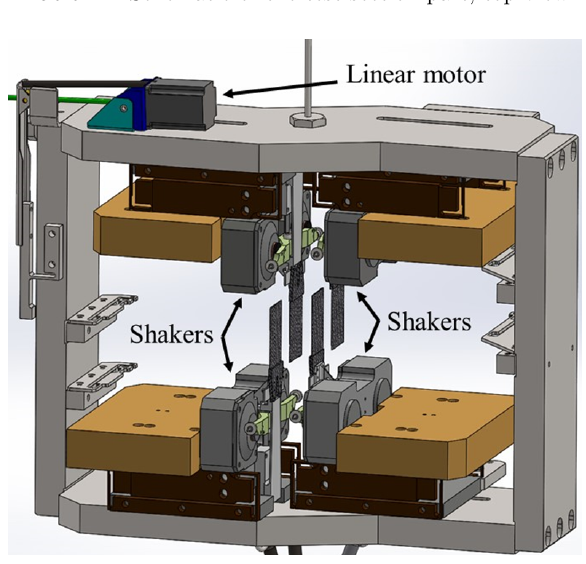
Figure 3. Supporting frame with four electromag- netic